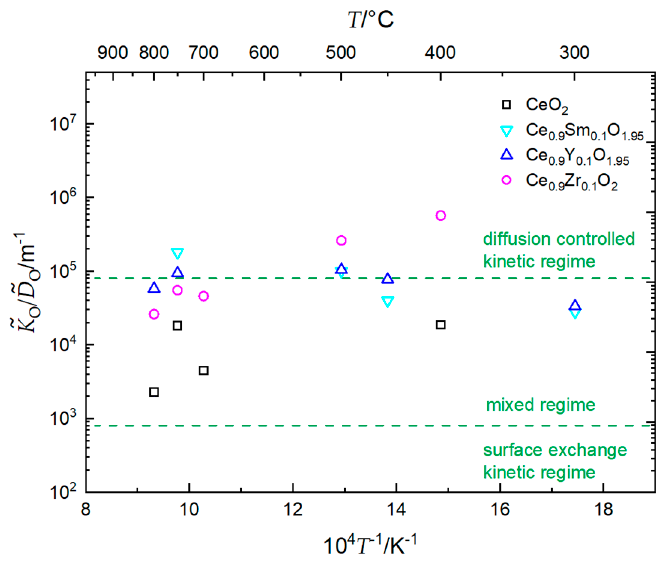
Figure 6. Calculated (cid:101) K O / (cid:101) D O ratios for non-equilibrium oxygen isotope exchange from C 18 O 2 together with the calculated regime boundaries in the temperature range from T = 300 ◦ C to T = 800 ◦ C for ceria containing 10 at-% of dopants (Y, Sm, Zr) and in nominally un-doped ceria samples. The boundaries for the kinetic regime were calculated according to L = h K with h = 1 mm and L being the characteristic dimensionless parameter of the kinetic regimes [30,35].